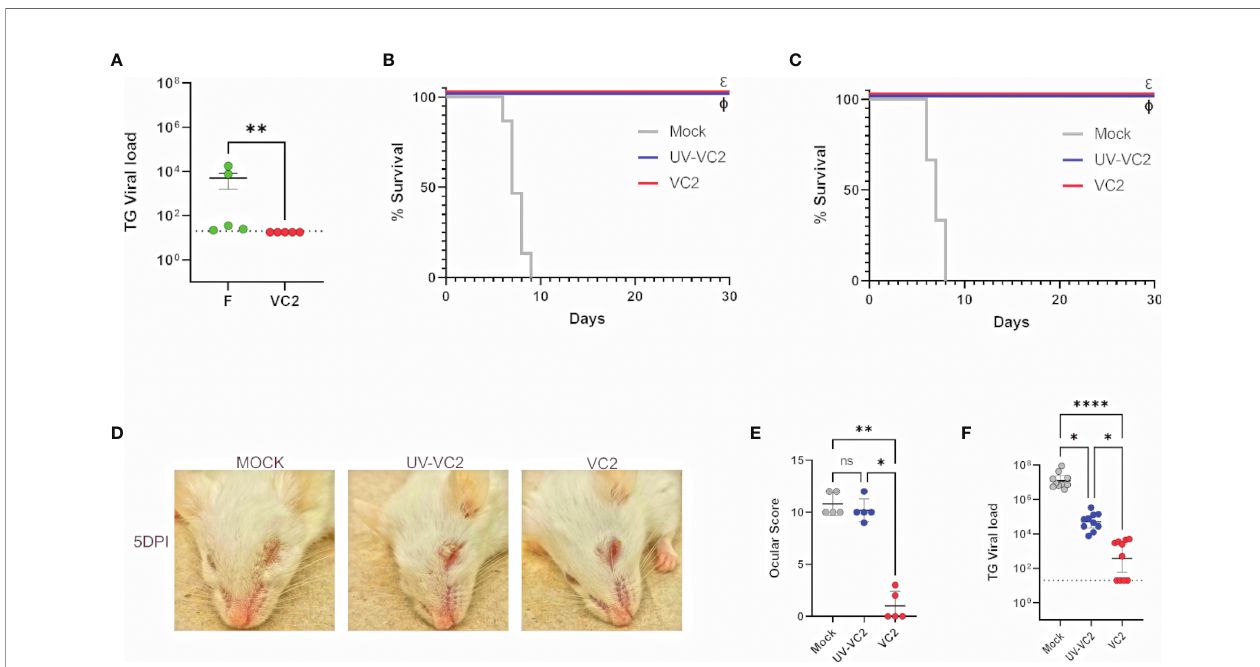
FIGURE 1 | Safety and protective ef fi cacy of VC2 immunization in Balb/CJ mice against HSV-1 (McKrae strain) ocular challenge. (A) Mouse eyes were scari fi ed and infected with HSV-1(F) or VC2 viruses at 10 6 PFU per eye and viral loads in TGs were quanti fi ed by qPCR at 20 days post infection. (B) Kaplan-Meir survival curves of mice immunized with either, VC2, UV-irradiated VC2 or mock-immunized and challenged with HSV-1 (McKrae strain) at 21 days post booster immunization. The experiment was duplicated with n=10/group each time. (C) Kaplan-Meir survival curves as with (B) challenged with HSV-1 (McKrae strain) at 8 months post booster immunization, n=10/group. (D) Representative pictures of animals in each group at 5 DPI. (E) Ocular scores following challenge at 5 DPI. (F) Quanti fi cation of TG viral load following euthanasia. *<P=0.05, ****<P=0.0001 by One-Way ANOVA. *<P=0.05, **<P=0.005, ****<P=0.0001. ns, Non-Signi fi